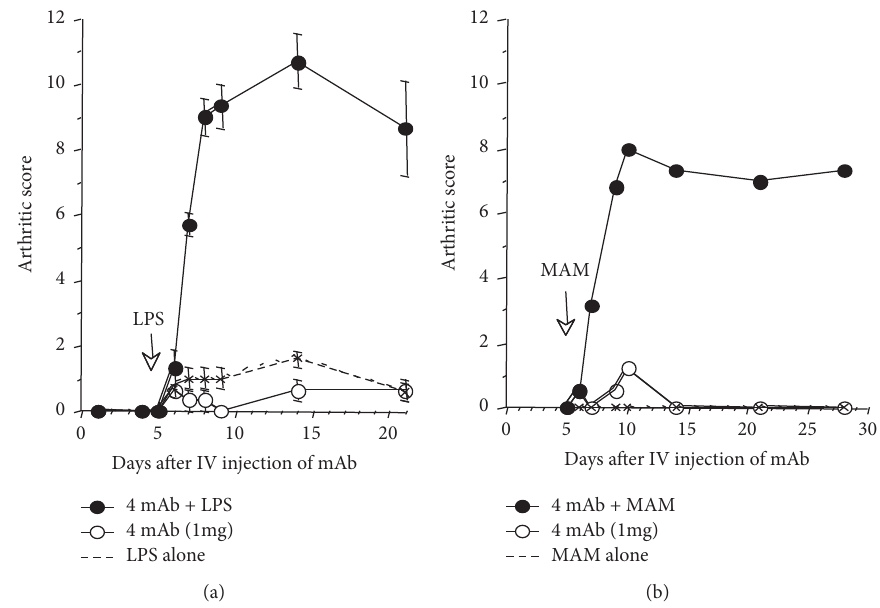
Figure 4: Synergistic effects of bacterial toxins to trigger and exacerbate arthritis in CAIA mice. CAIA in two mouse strains (DBA/1 and B10.RIII) was established by IV injection of the arthritogenic four-clone monoclonal antibody cocktail (1mg) on day 0 and subsequent IP injection of 50 μ g of lipopolysaccharide (LPS) from E. coli (a), or mycoplasma arthritidis mitogen (MAM) (b) on day 3. Mice developed arthritis within 24–48 hours after receiving the toxins and the arthritic score plateaus 7-8 days later and can last up to 30 days. (a) mAb plus LPS in DBA/1 mice. (b) mAb plus MAM in B10.RIII mice. Table 1: Similarities and differences between CAIA and CIA animal models. CFA: Complete Freund’s adjuvant, RA: rheumatoid arthritis, CIA: Collagen-Induced Arthritis, and CAIA: Collagen Antibody-Induced Arthritis. CIA model CAIA model Induction method Type II collagen/CFA Monoclonal antibodies against type II collagen Feature of arthritis Polyarthritis